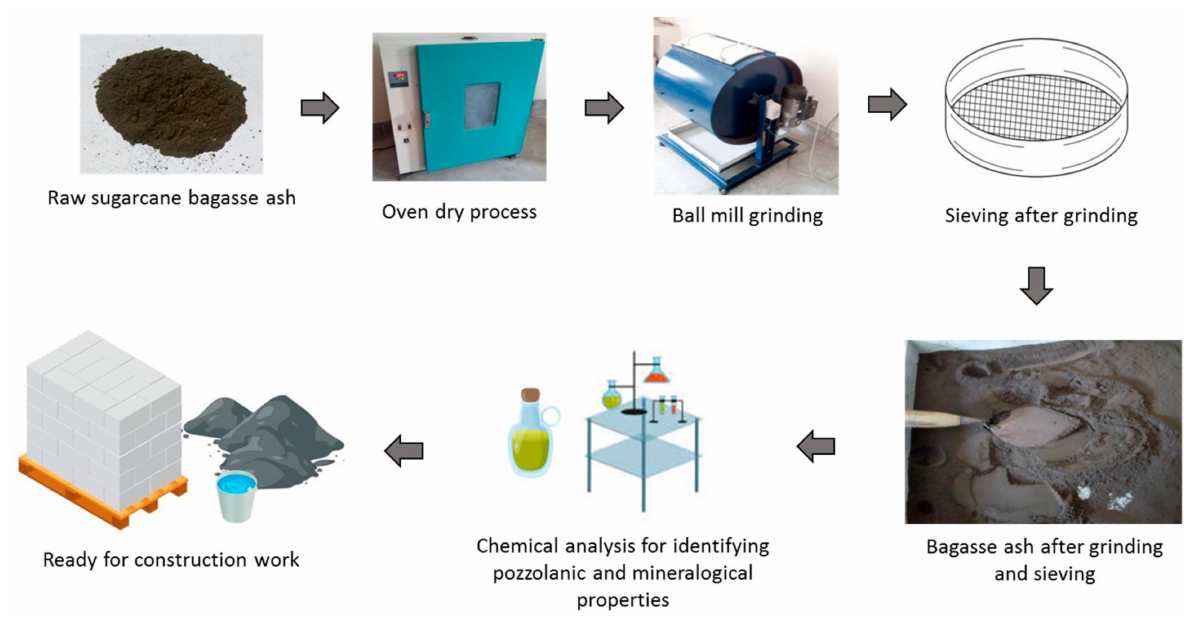
Figure 5. Simple process of utilizing sugarcane BA in construction industry.